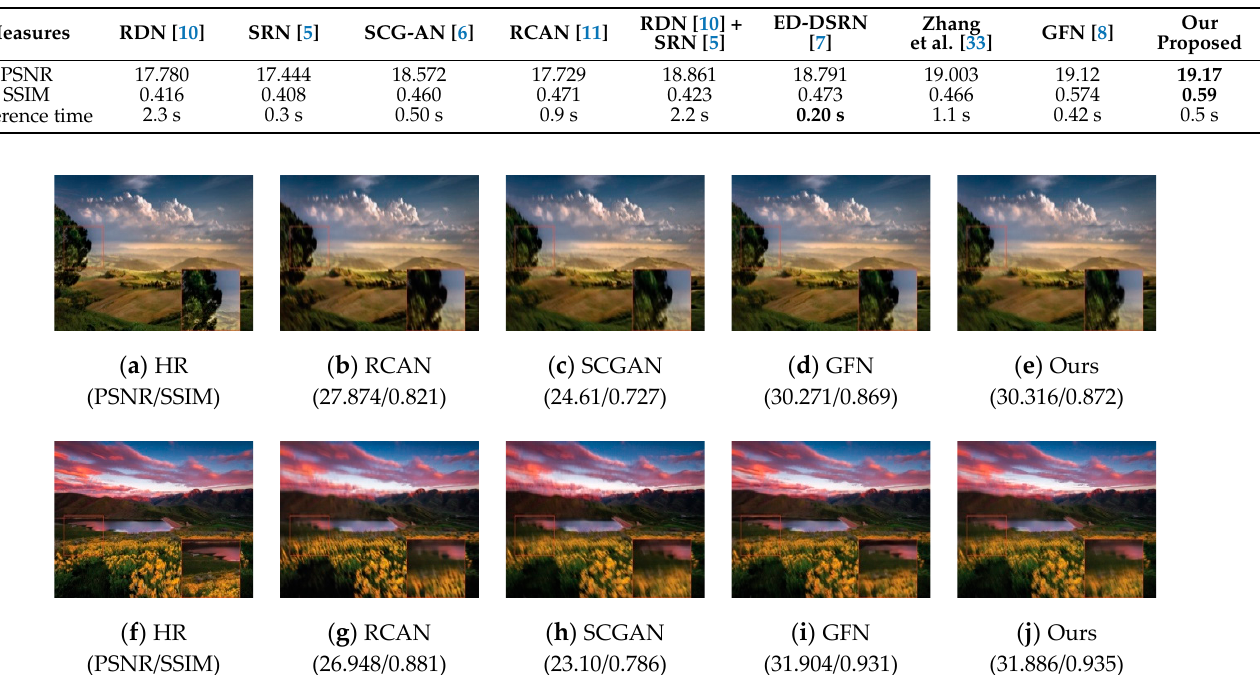
Figure 4. More visual comparison of our model with other methods on GOPRO [2].